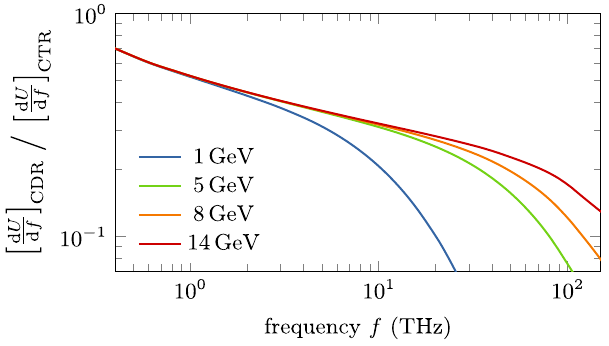
FIG. 1. Spectral energy density of CDR for several electron beam energies relative to CTR. For CDR, a 32 mm wide screen with an aperture of 5 mm (diameter) was assumed.